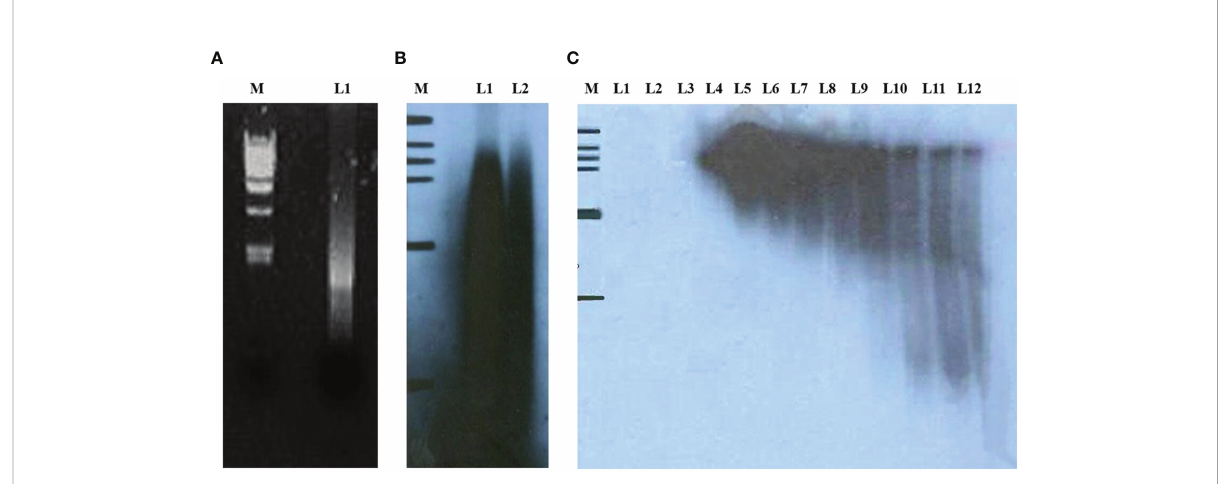
chromatographically and collected by Sepharose CL-2B gel column after non-denaturing polyacrylamide gel